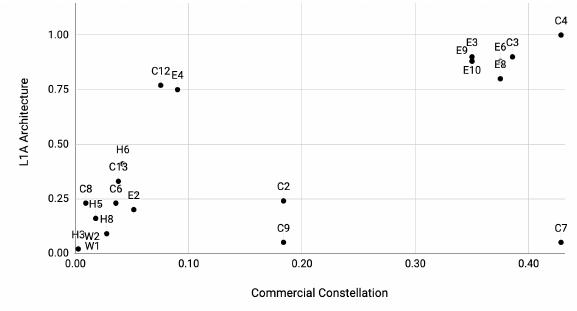
Figure 1 . Commercial assessment scores against L1A architecture for GOs with heuristic accuracy.